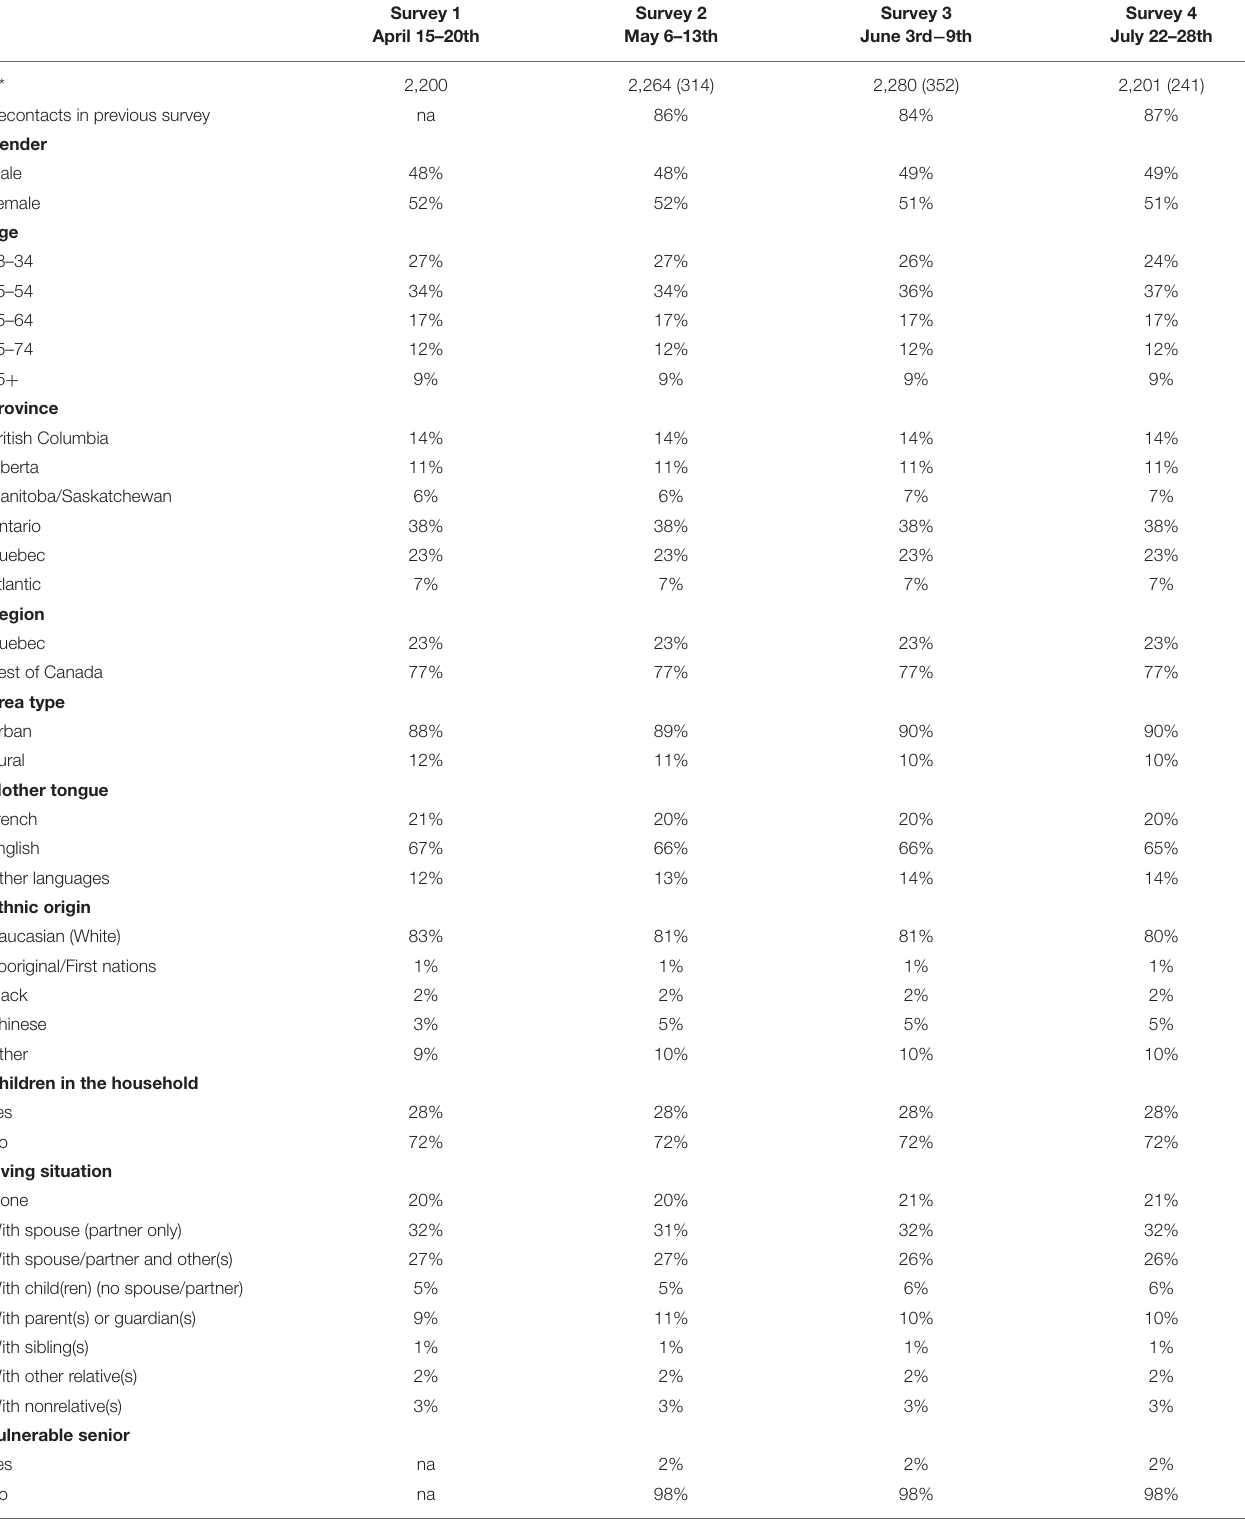
TABLE 1 | Profile of the participants in each